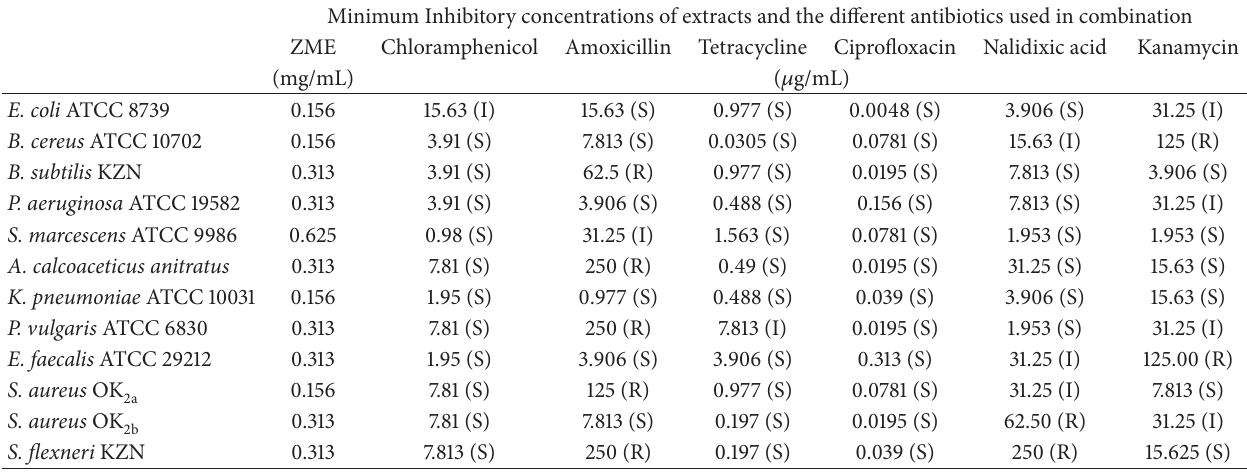
Table 2: Susceptibility of the bacterial isolates to Ziziphus mucronata extract and the antibiotic.